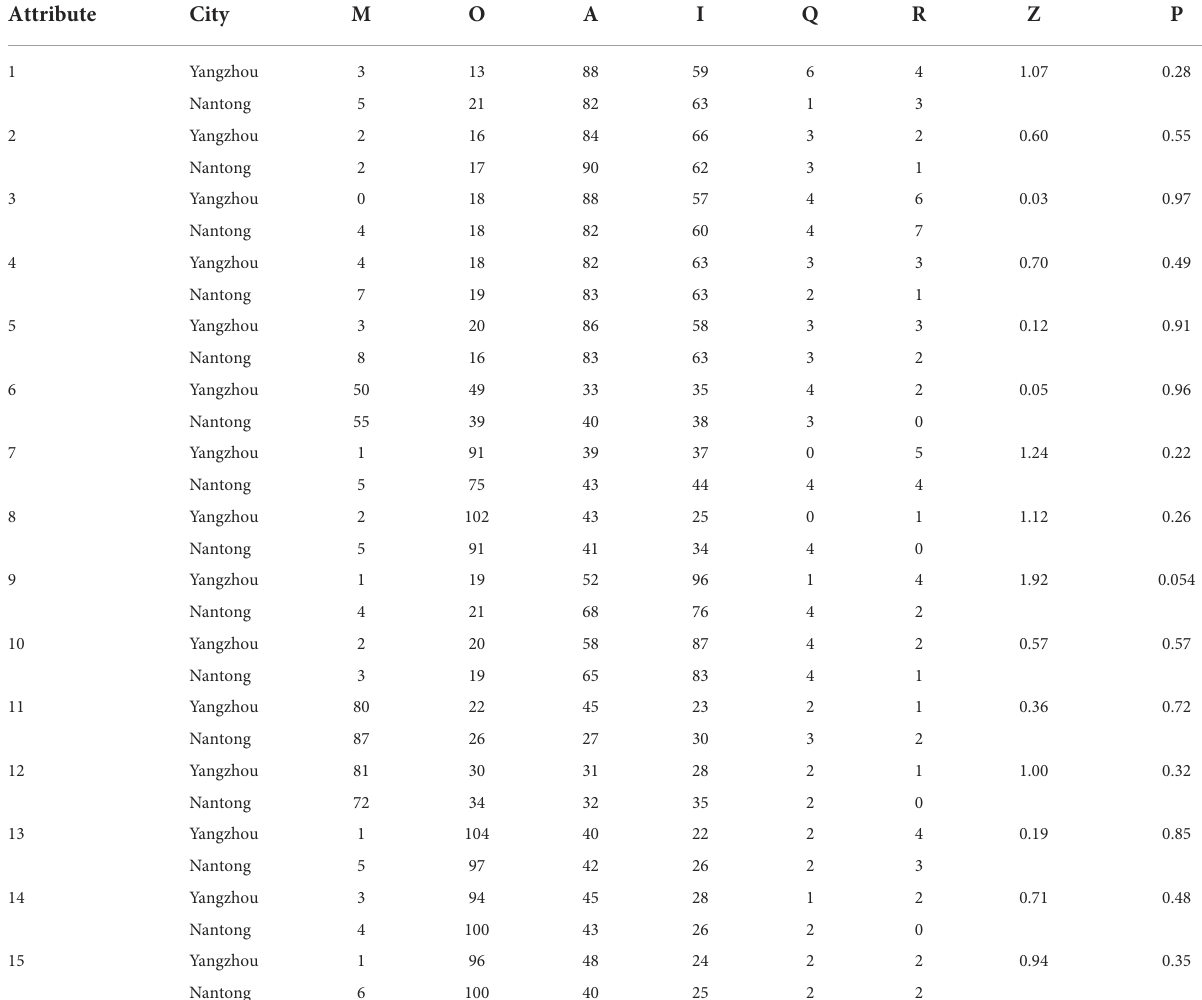
TABLE 5 The differences in telenursing demands between Yangzhou and